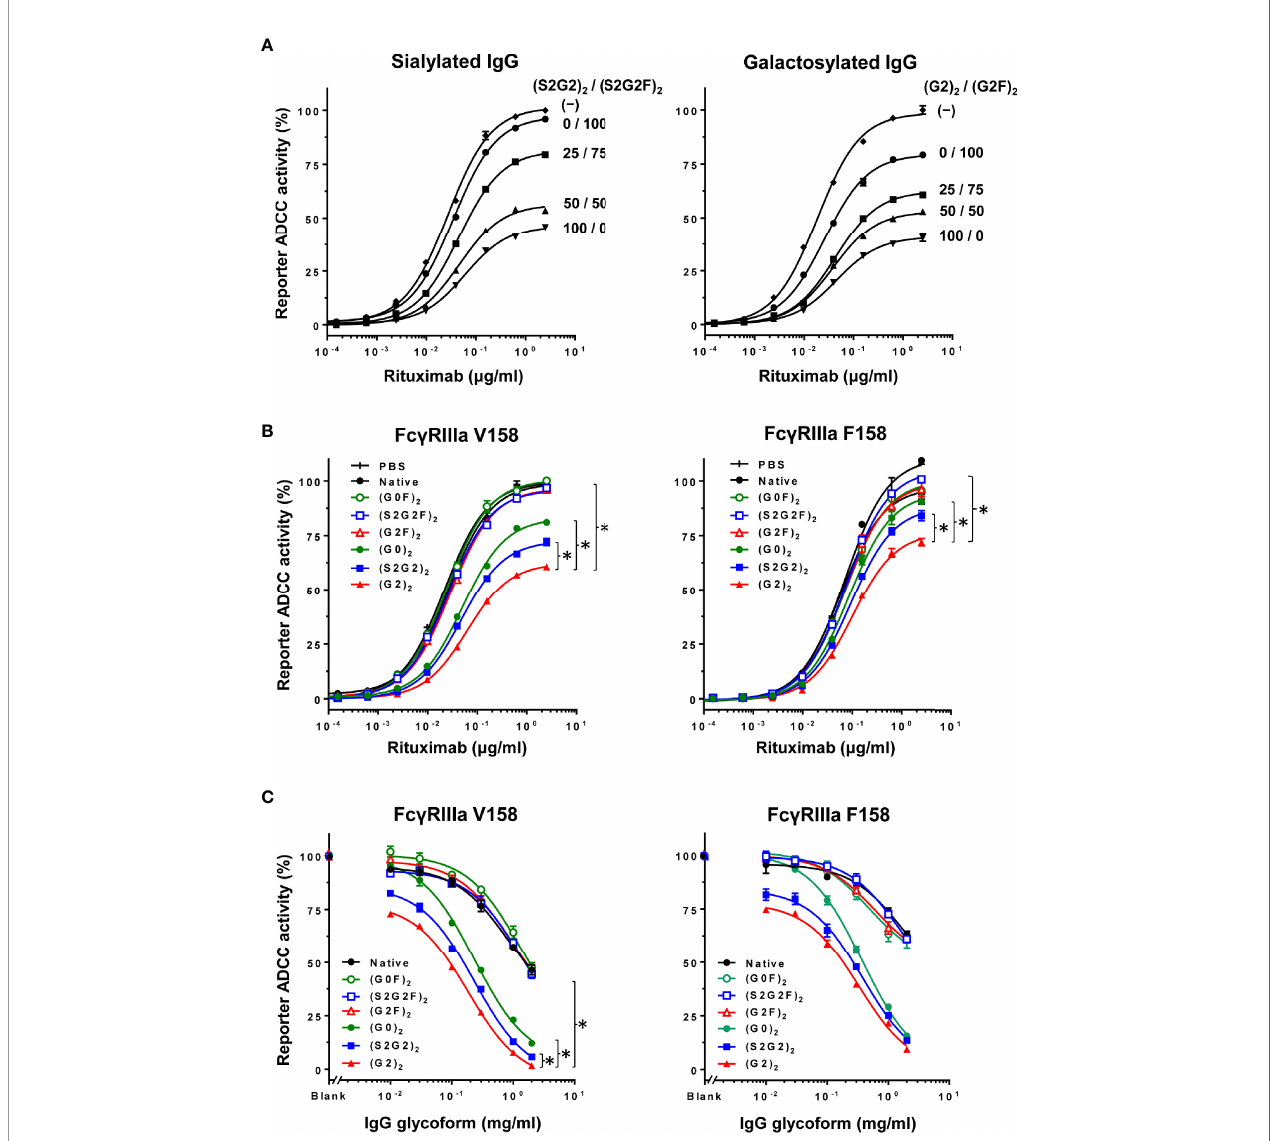
FIGURE 4 | Inhibition of ADCC with normal IgG is glycoform-dependent. (A) In fl uence of fucosylation of normal IgG on inhibition of ADCC was examined by titration of fucosylation levels of sialylated glycoforms (left) and galactosylated glycoforms (right) at the fi nal concentration of 0.2 mg/ml. Error bars, mean ± S.E. (n = 3). (B) In fl uence of the IgG glycoforms on inhibition of ADCC was examined at 0.1 mg/ml of each IgG glycoform. Error bars, mean ± S.E. (n = 3). Note that the differences in